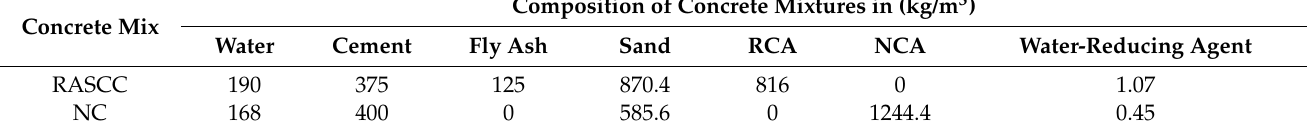
Table 2. Mix proportion of concrete.